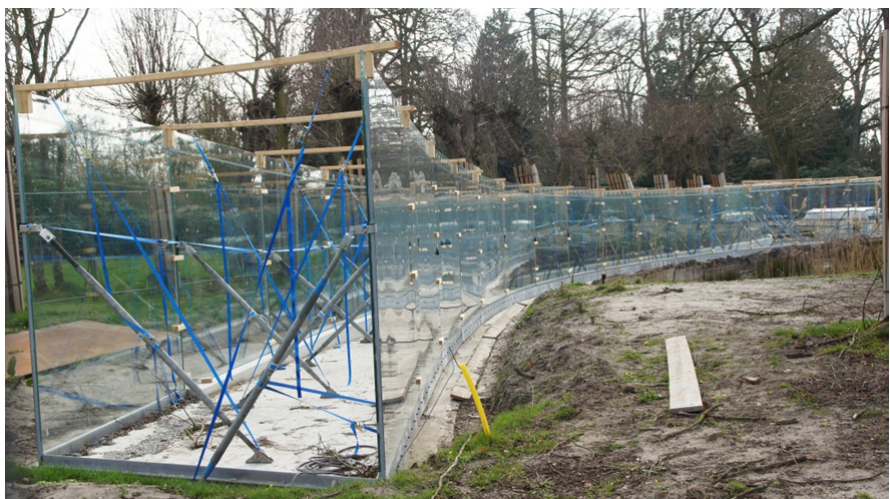
Fig. 15 End of wing, under construction, visible is the clamping in the